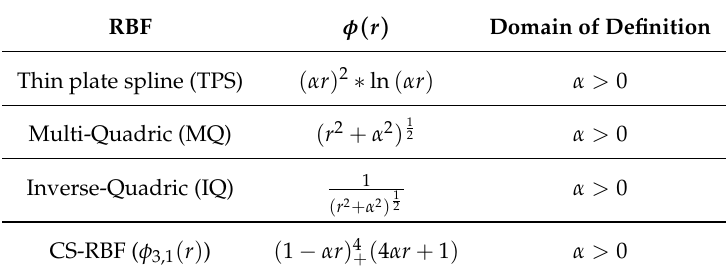
Table 5. The four kinds of RBFs.